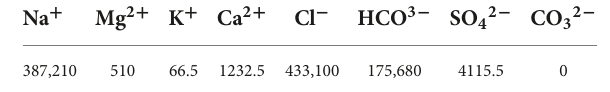
TABLE 1 Concentrations of main salt ions in the Yellow River Delta (Unit: